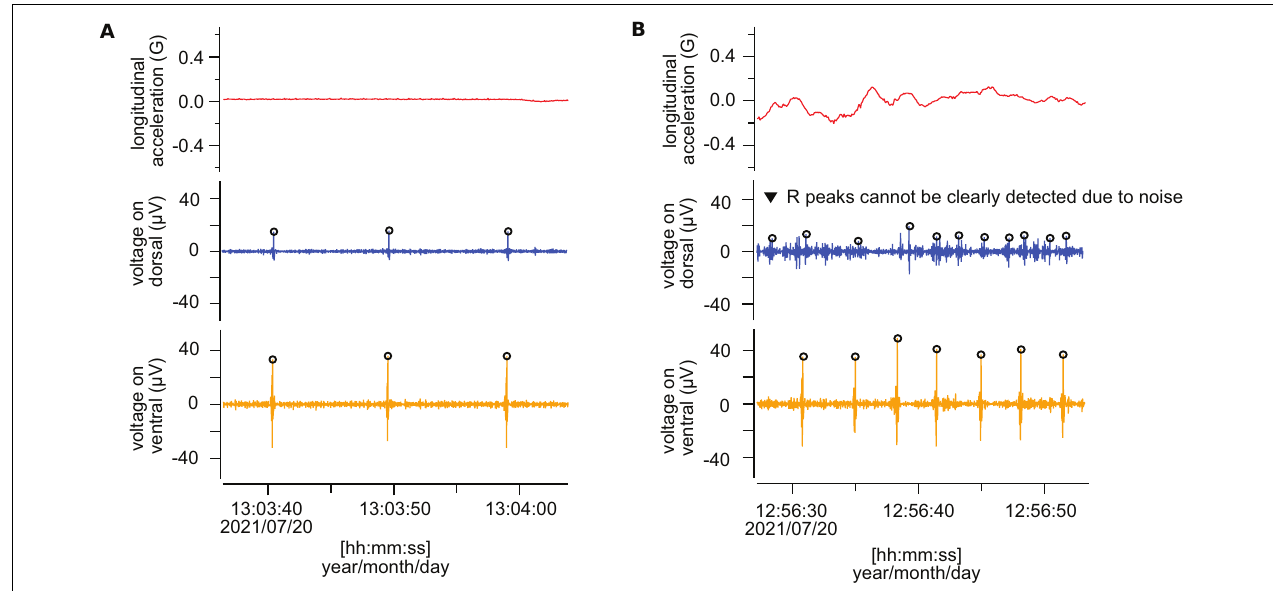
FIGURE 4 | Comparison of the measured ECG (after filtering) from dorsal and ventral sides. (A,B) Show resting phase and active phase, respectively. Red, blue, and orange lines indicate longitudinal acceleration, ECG from dorsal and ventral sides, respectively. The open circles show the points judged as R wave by the program in Sakamoto et al. (2021). All panels show the data from L2110.